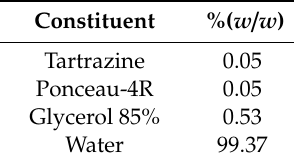
Table 2. Coating liquid